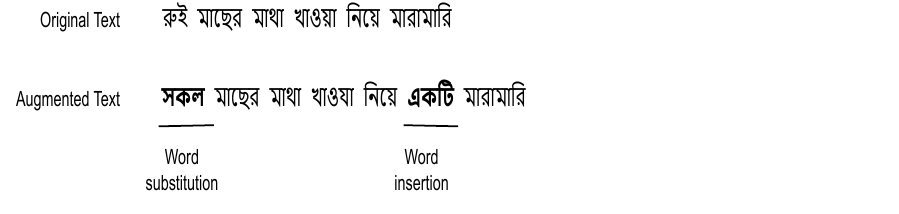
Figure 3. The original text from the training data and the augmented data using insertion and substitution of